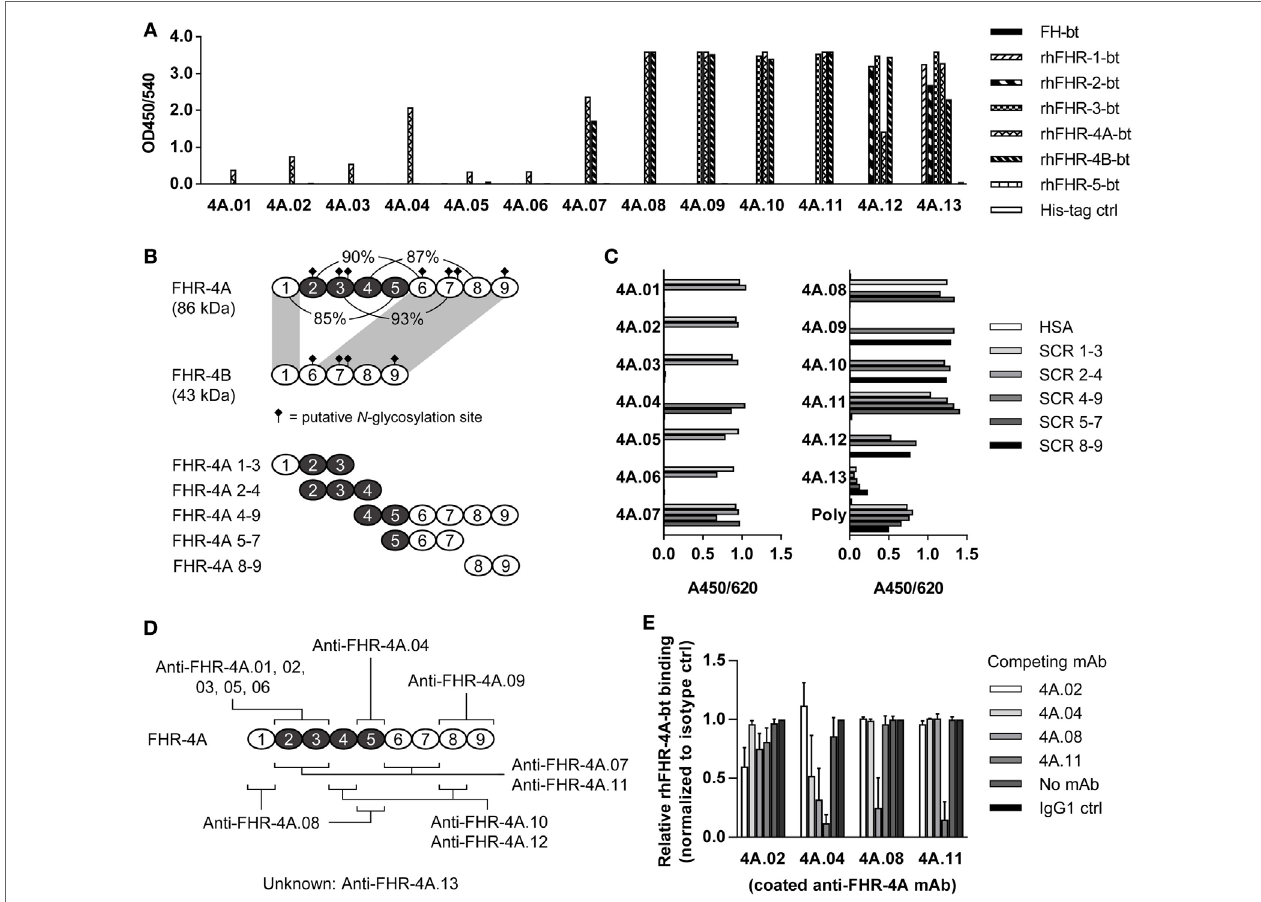
FigUre 1 | Characterization of anti-FHR-4A monoclonal antibodies (mAbs). (a) Cross-reactivity of the anti-FHR-4A mAbs to biotinylated rhFHR proteins and biotinylated plasma-derived FH was determined by ELISA. (B) Schematic representation of FHR-4A, FHR-4B, and the recombinant fragments of FHR-4A used for epitope mapping, with the duplicated SCR domains in FHR-4A depicted in black. Corresponding percentage of sequence identity between the domains in FHR-4A is indicated. Domains 1 and 6–9 of FHR-4A are completely identical to the domains of FHR-4B (indicated by gray shading). (c) Epitope mapping of anti-FHR-4A antibodies using the fragments of rhFHR-4A as depicted in (B) , determined by ELISA. As a control, polyclonal anti-FHR-3 (poly), which cross-reacts with all FHR proteins was used. (D) Schematic representation of the epitope location of each of the anti-FHR-4A mAbs. Single epitope mAbs are listed above FHR-4A, mAbs with multiple epitopes below. Note that most cross-reactive mAbs have two epitopes in FHR-4A, due to the high sequence similarity of the SCR domains. (e) Competition ELISA with monospecific mAbs (anti-FHR-4A.02 and 4A.04) and cross-reactive mAbs (anti-FHR-4A.08 and 4A.11). Binding of biotinylated rhFHR-4A is expressed as relative to the binding of biotinylated rhFHR-4A without any competing mAb. Bars represent mean of independent replicates with error bars indicating SD. All graphs are representative of multiple independent